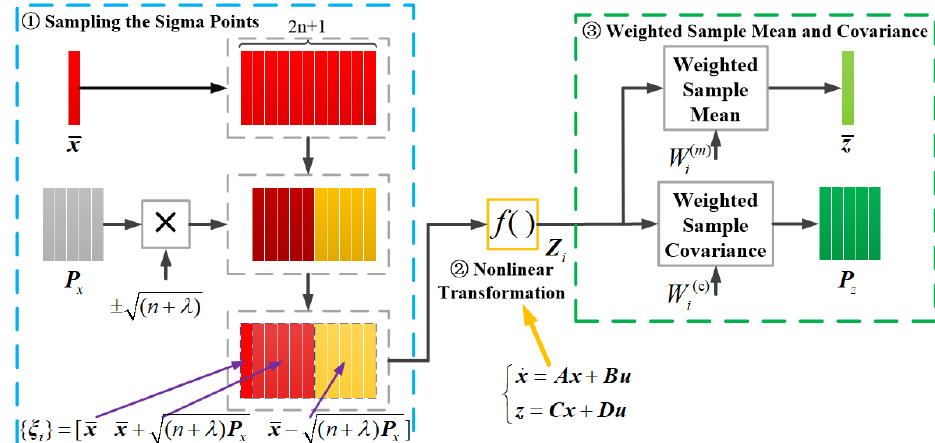
Figure 2. The flowchart of UT.